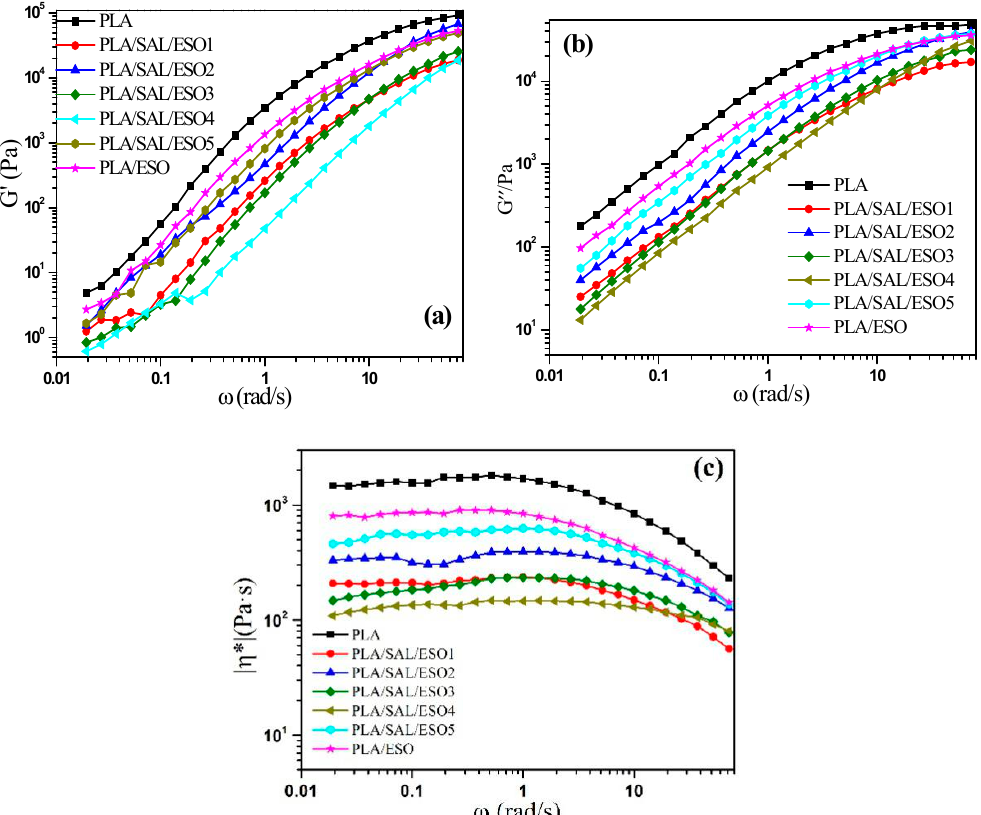
Figure 6. Frequency ramp sweep curves for pure PLA, PLA / ESO, and PLA / SAL / ESO composites at 170 °C: ( a ) storage modulus ( G ´), ( b ) loss modulus ( G ´´), and ( c ) complex viscosit y (| η * |).